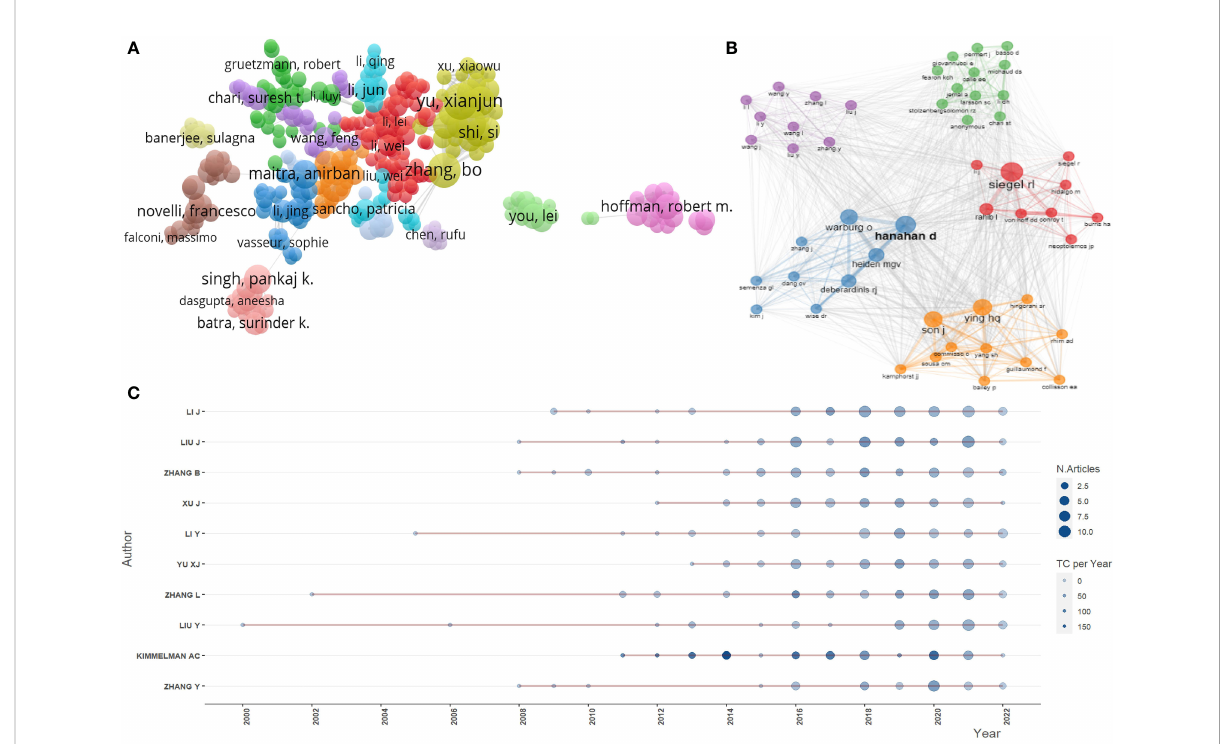
FIGURE 4 Visualization of active institutes and authors analysis. (A) Network map showing cooperation among authors; (B) Cluster analysis of cooperation among institutes; (C) Timeline distribution of the top 10 most productive